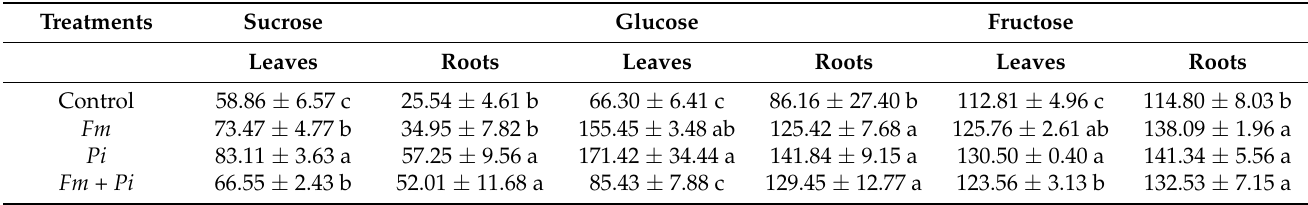
Table 2. Effects of Piriformospora indica ( Pi ) and Funneliformis mosseae ( Fm ) singly and in combination on tissue concentration (mg/g DW) of sucrose, glucose, and fructose in trifoliate orange seedlings.